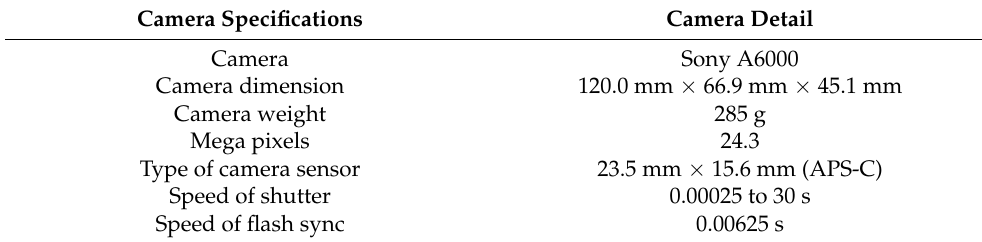
Table 8. Sony A6000 camera parameters.